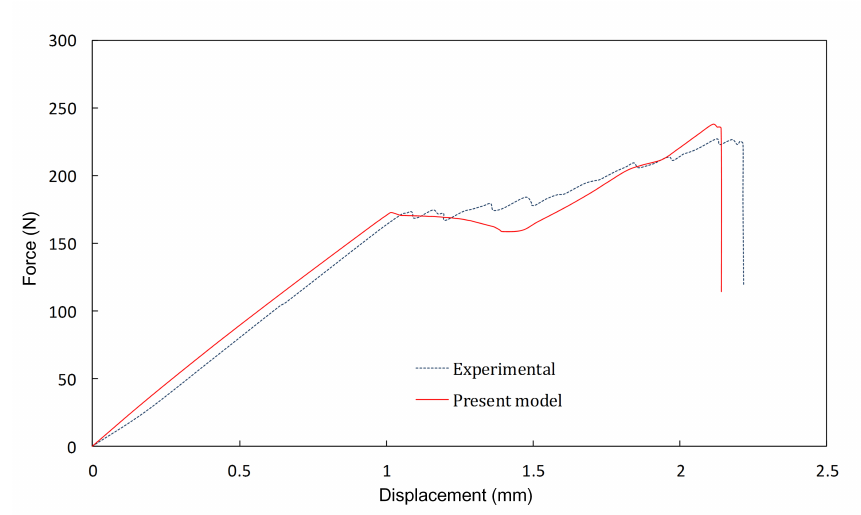
Figure 12. Comparison of the simulated and experimental force-displacement